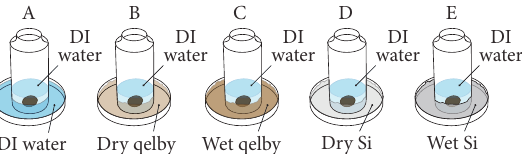
Figure 2: Noncontact model: diagrammatic representation of brown chickpeas immersed in deionized water (DI) water contained in liquid scintillation vials. The vials were surrounded by one of several materials contained in petri dishes: DI water, dry/wet QE or Si.